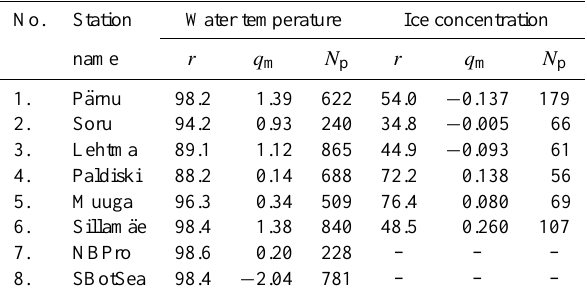
Table 2. Measurement stations used for the model calibration and comparative statistics between the observations and modelling re- sults for these stations ( r : correlation coefficient in %; q m : mean difference between observations and model; N p : number of data points). Station numbers as in Fig. 1.